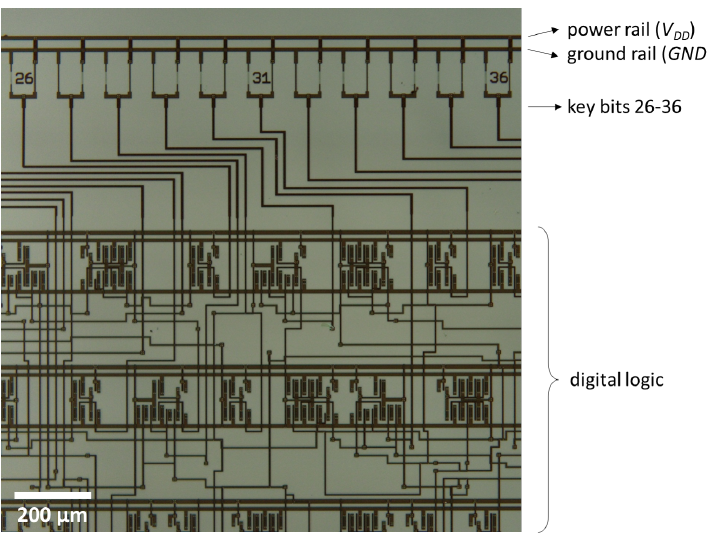
Figure 6: Microscope image of key bits 26-36 and part of the logic gates.